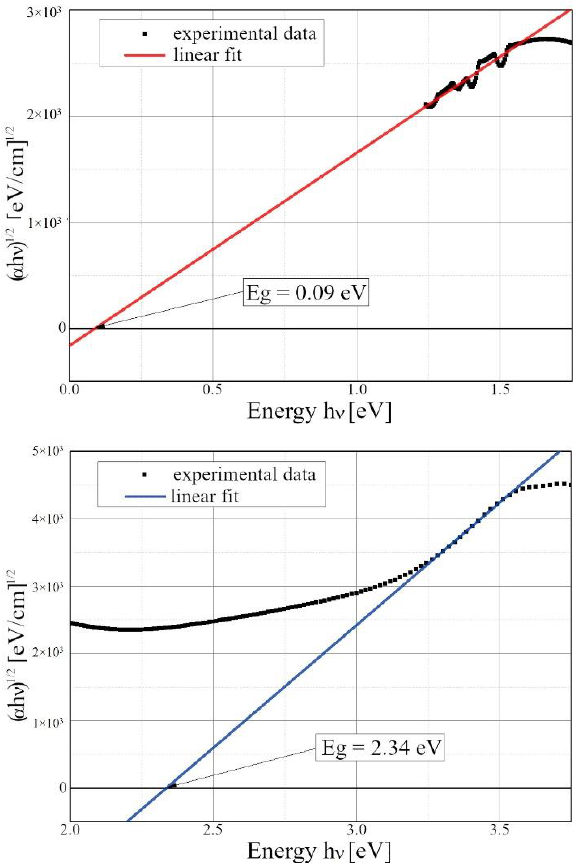
Figure 4. UV – VIS spectrum of monoclinic CuPPD and silver oxide nanocrystals restricted in SBA-15 mesoporous silica (black dots). According to Equation (2), linear fit indicates the energy gap width E g . The vertical axis is a square root of a product of absorption coefficient and the energy of radiation (n =